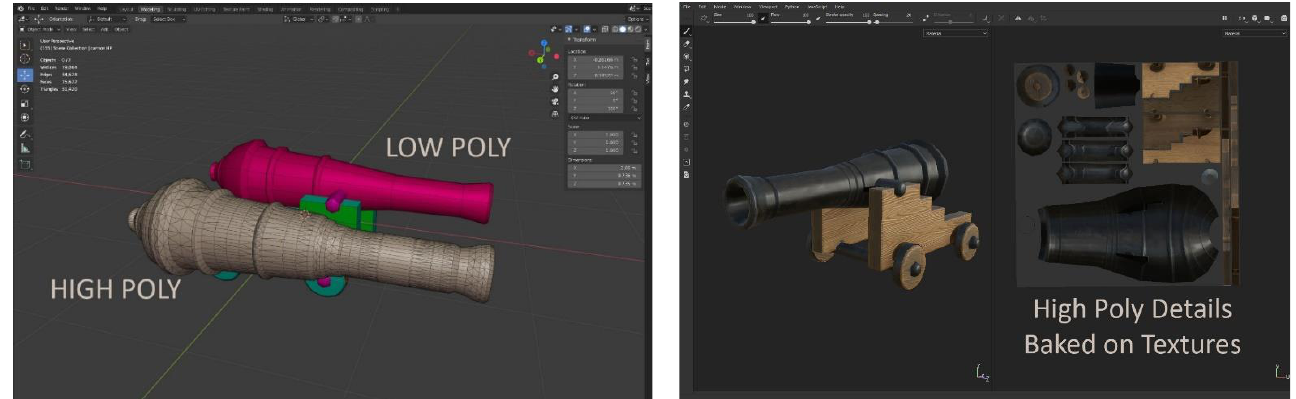
Figure 9 . High poly to low poly workflow example. Screenshot from Blender and Adobe Substance 3D Painter.